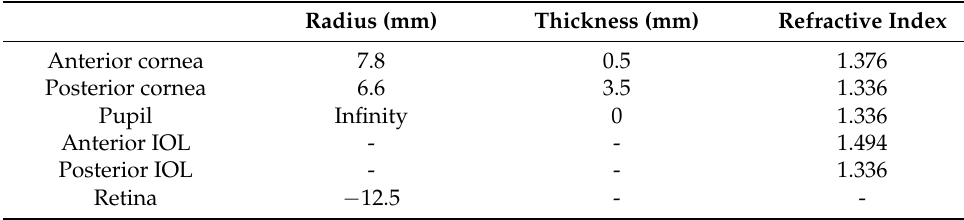
Table 1. Structural parameters of the pseudophakic eye